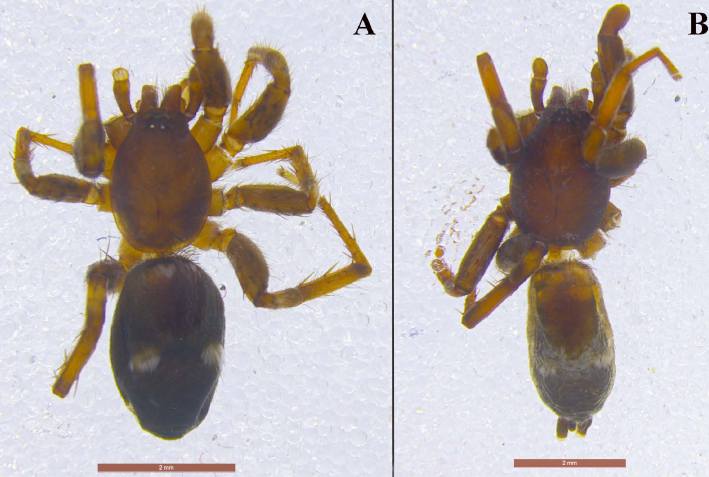
Figure 11. Phaeocedus similaris n.sp. (holotype) ( A ) and P. vankeeri (holotype) ( B ), males,